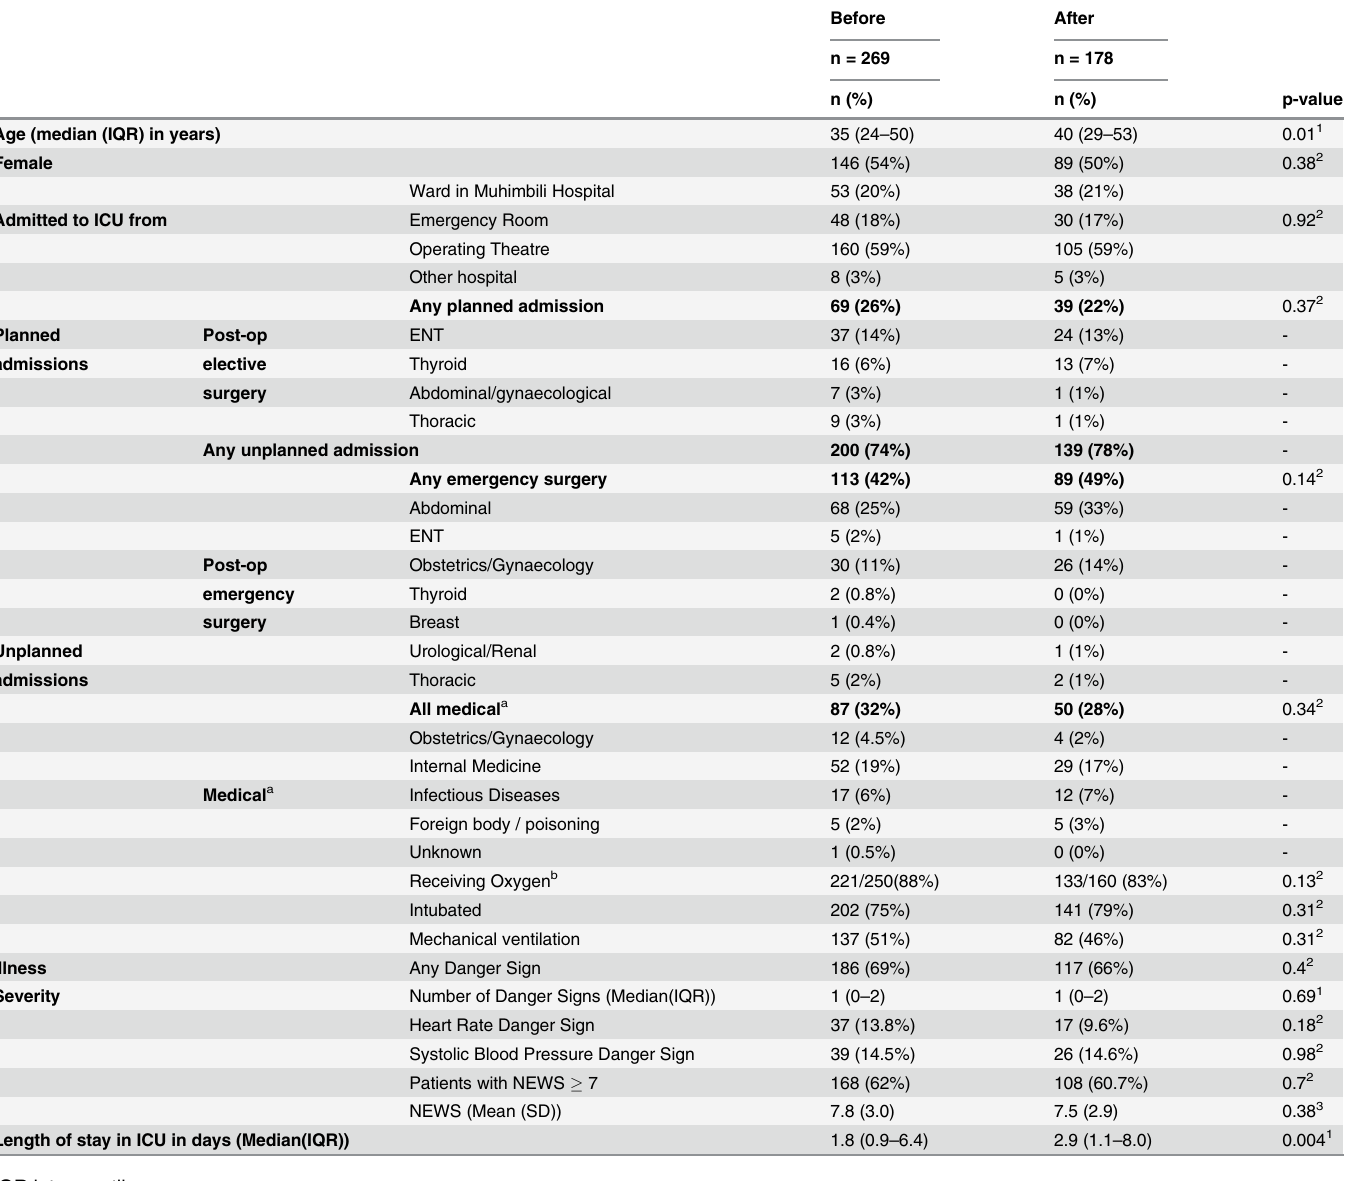
Table 1. Patient Characteristics. Age, sex, admitting ward, admitting specialty, illness severity and length of stay for all patients over 16 years in the